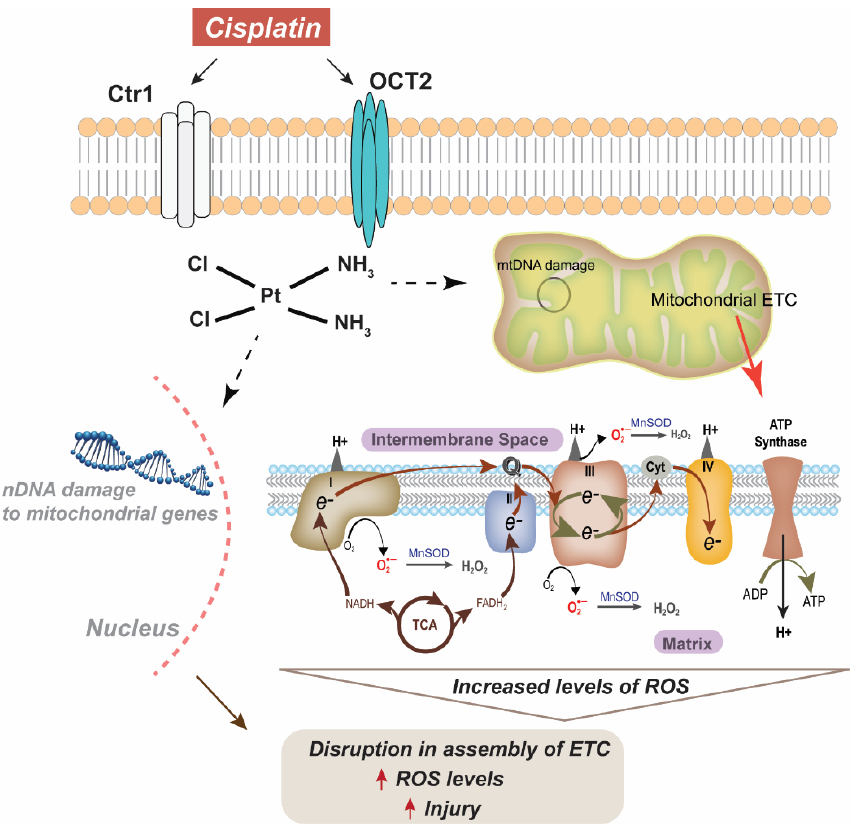
Figure 1. Scheme for cisplatin-induced injury via damage to both nuclear (nDNA) and mitochondrial DNA (mtDNA). Ctr1: copper transporter 1, OCT2: organic cation transporter 2, MnSOD: manganese superoxide dismutase, ROS: reactive oxygen species, ETC: electron transport chain.